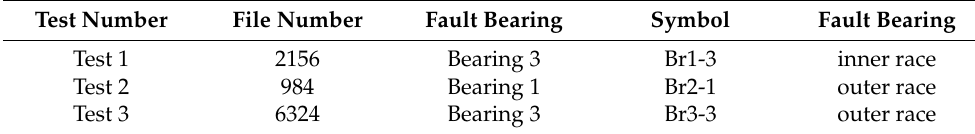
Table 2. Description of IMS